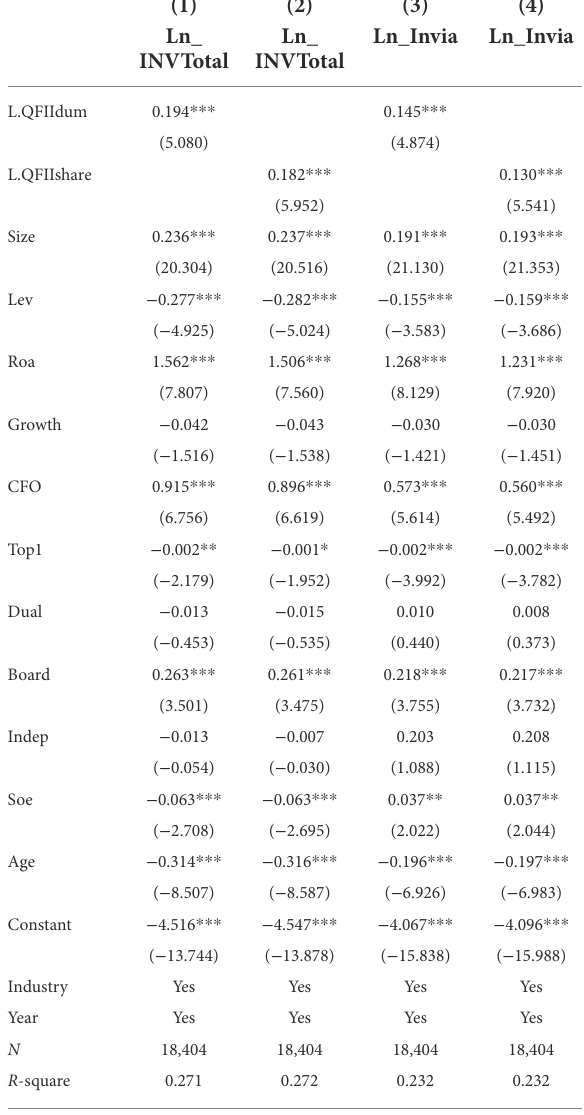
TABLE 10 Robustness test: the impact of QFII on corporate innovation with one period